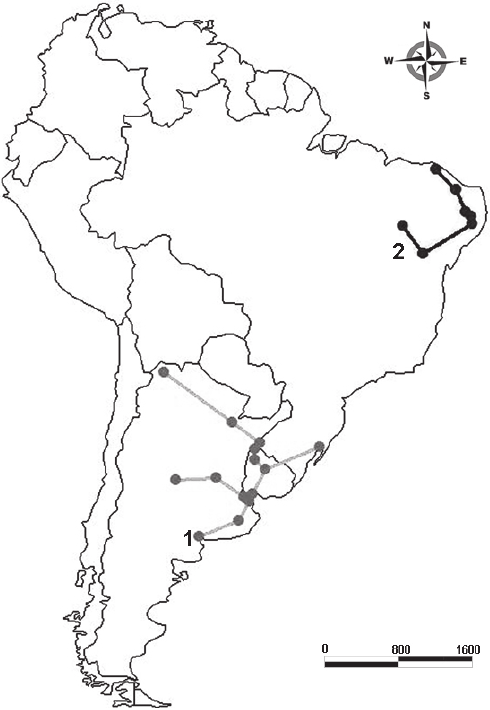
Fig. 19 - Individual tracks of Panochthus (1 - Panochthus tuberculatus ; 2 - P. greslebini